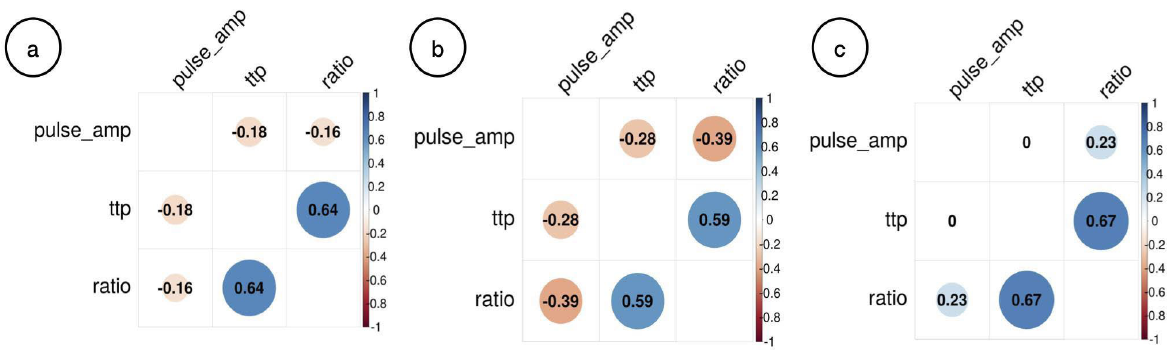
Figure 2. Joint Correspondence analysis of all the observations obtained from the data collection ( a ), case group ( b ), and control group ( c ). pulse_amp = Pulse amplitude; ttp = Time to peak; ratio = P2/P1 ratio.